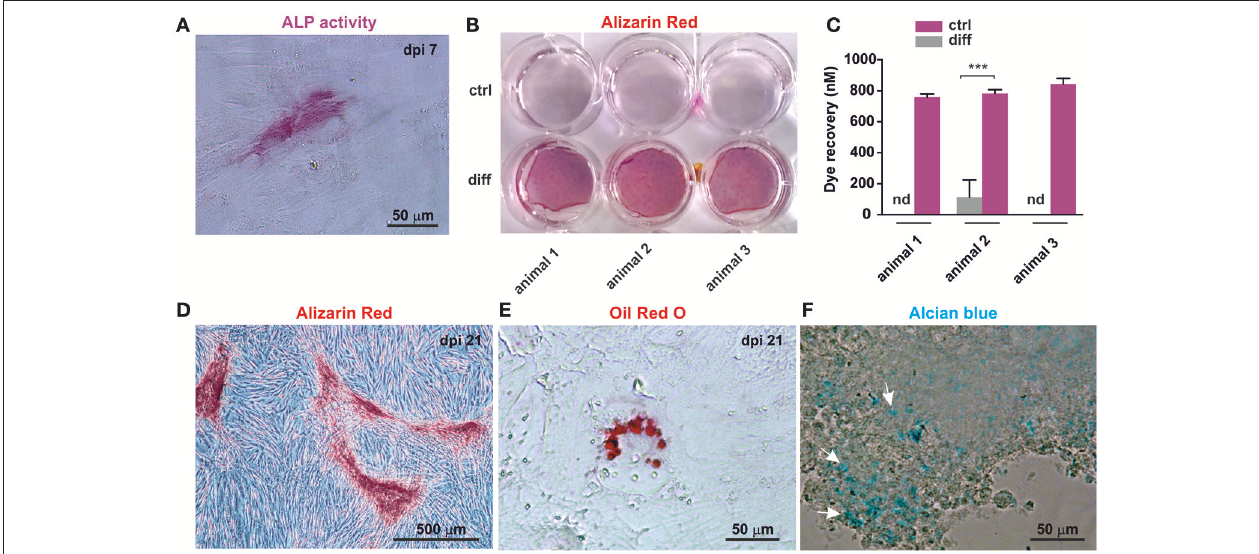
FIGURE 5 | oNCSCs are capable of differentiating into osteogenic, adipogenic, and chondrogenic cell types. (A) oNCSCs cultivated in osteoinductive medium for 7 days show alkaline phosphatase (ALP) activity. Scale bar: 50 µ m. (B,C) Alizarin red stain and dye recovery assays revealed that oNCSCs cultivated for 21 days in osteogenic differentiation medium ( B : lower wells; C : magenta bars) deposit significantly higher levels of calcium deposits compared to control cells *** P < 0.0001. (D) Magnified picture of a representative culture of oNCSCs– derived osteocytes (21 days) stained with alizarin red. Scale bar: 500 µ m. (E) oNCSCs differentiate into adipocytes as indicated by the presence of lipid droplets stained with Oil Red O. Scale bar: 50 µ m. (F) After 21 days of chondrogenic differentiation, oNCSCs pellets express glycoproteins as indicated by alcian blue staining (arrows). Scale bar: 50 µ